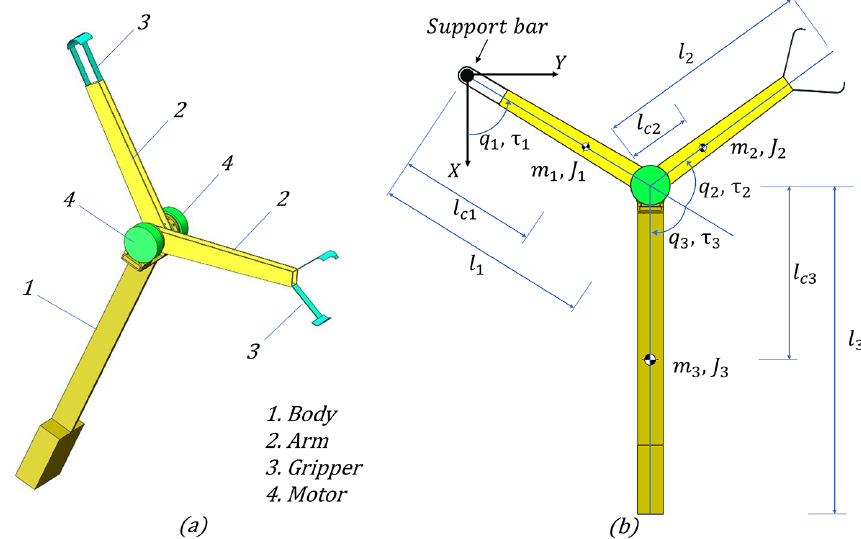
Figure 2. (a) The brachiation robot. (b) The plane control model of the brachiation